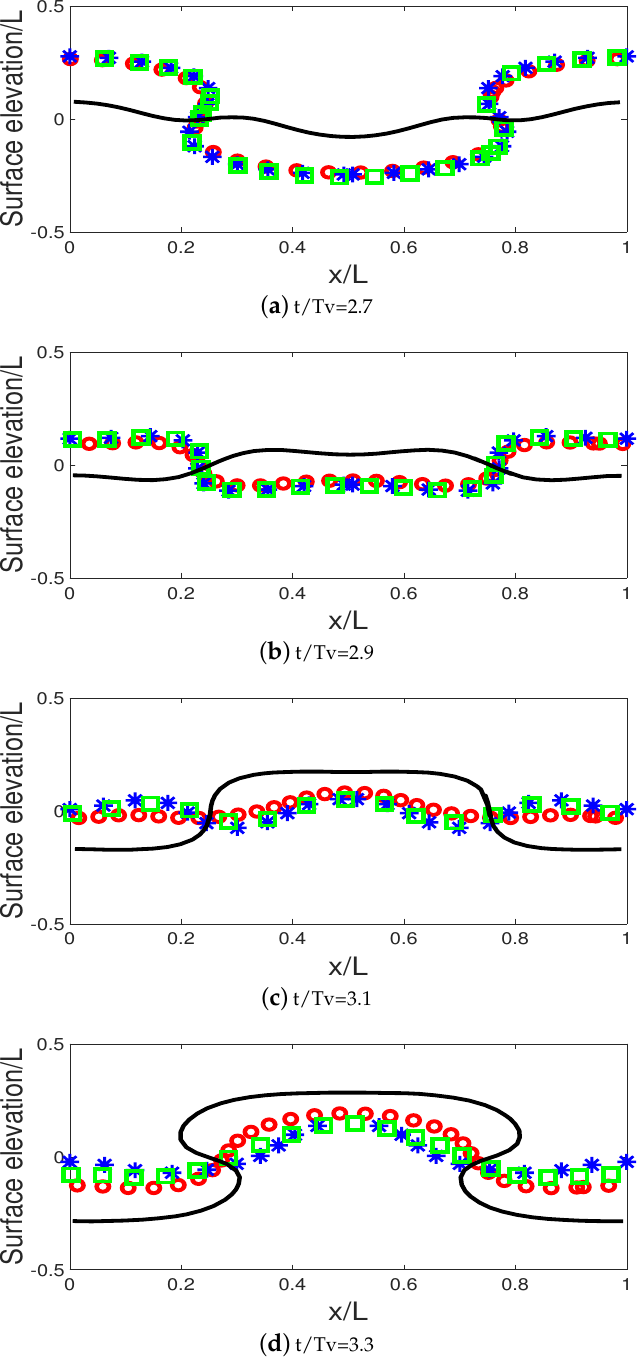
Figure 6. Comparison of the interface shape evolution—Nonlinear case with inverted acceleration. ( − ) PF S [15], ( ◦ ) FT S (this work), ( ∗ ) EbFVM S (this work), ( (cid:3) ) VOF S (this